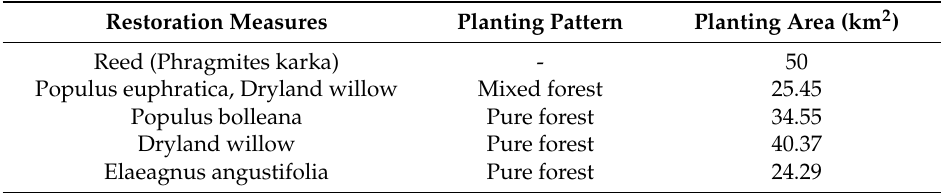
Table 1. The recommended scheme for the wetland restoration